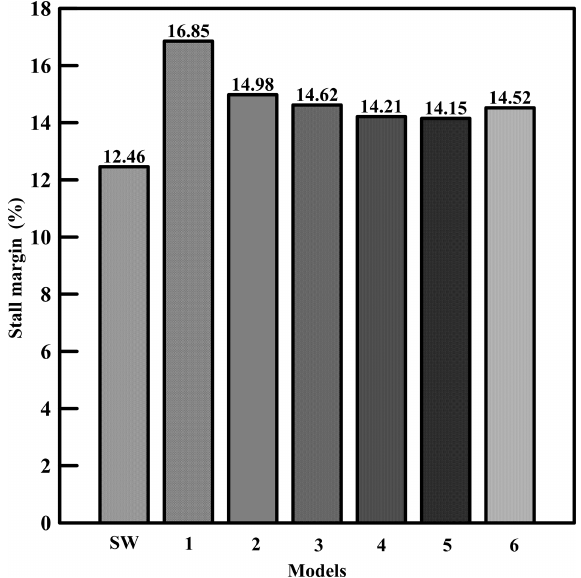
Figure 10. Comparison of stall margin of smooth casing and mod- els